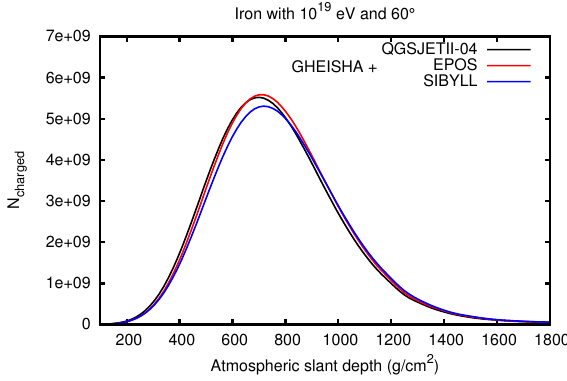
Figure 3. Number of charged particles given by GHEISHA alter- natively combined with high energy hadronic interaction models QGSJETII-04, EPOS and SIBYLL, for an incoming primary iron with E = 10 19 eV and θ = 60 ◦